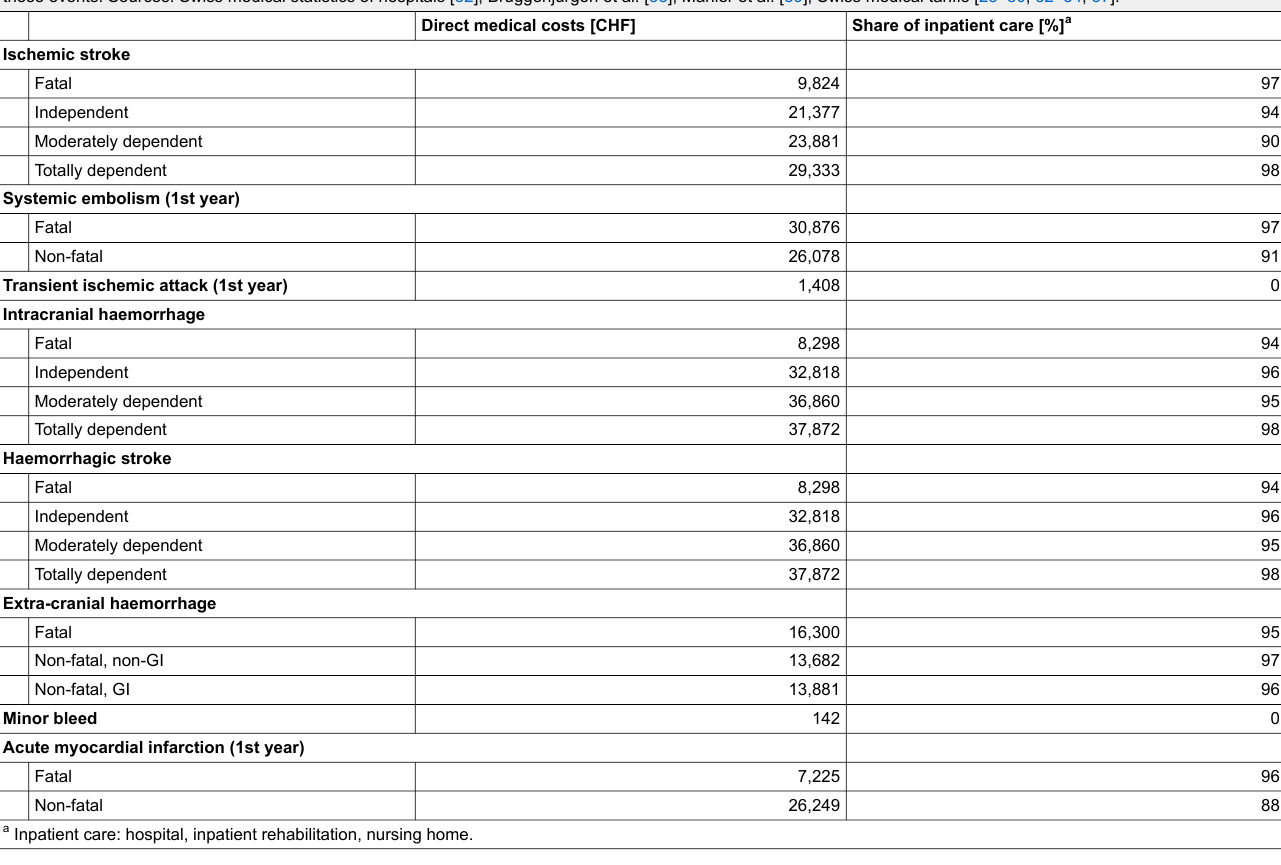
Table 1 : Event costs of clinical events in the first 3 months. Clinical event costs are the direct medical costs in the first 3 months after an event. For SE, TIA, and AMI, they include the cost of the first year because these events are treated for longer than just 3 months in Switzerland and the model does not allow long-term follow-up costs for these events. Sources: Swiss medical statistics of hospitals [32], Brüggenjürgen et al. [38], Mahler et al. [39], Swiss medical tariffs [28–30, 32–34, 37].